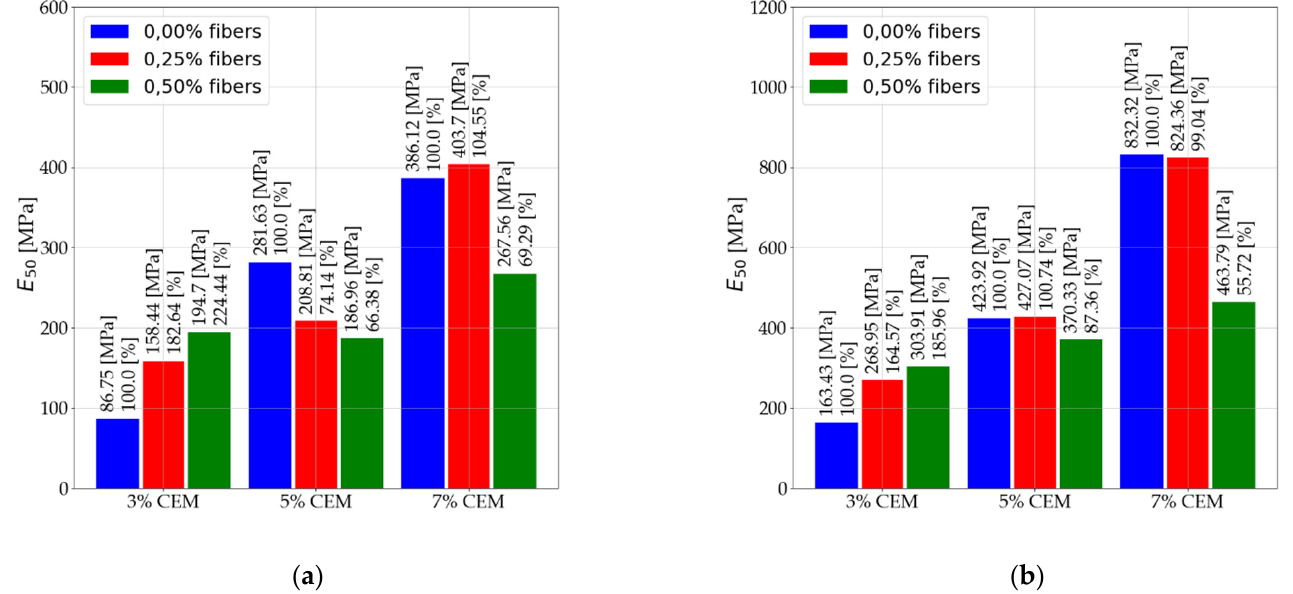
Figure 8. Values of secant modulus E (cid:2873)(cid:2868) after 7 days of care ( a ) before interpretation and ( b ) after interpretation.